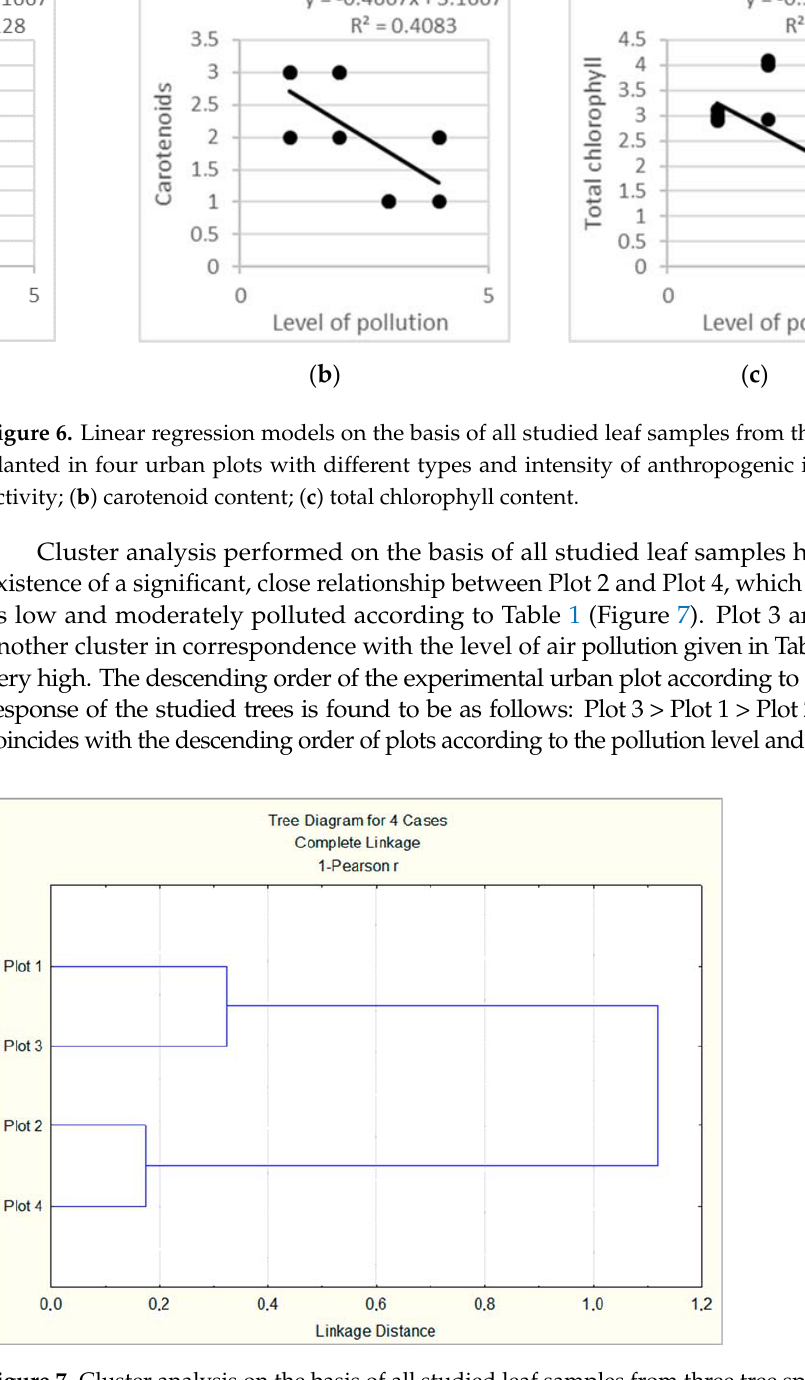
Figure 7. Cluster analysis on the basis of all studied leaf samples from three tree species, planted in four urban plots with different types and intensity of anthropogenic impact. four urban plots with different types and intensity of anthropogenic